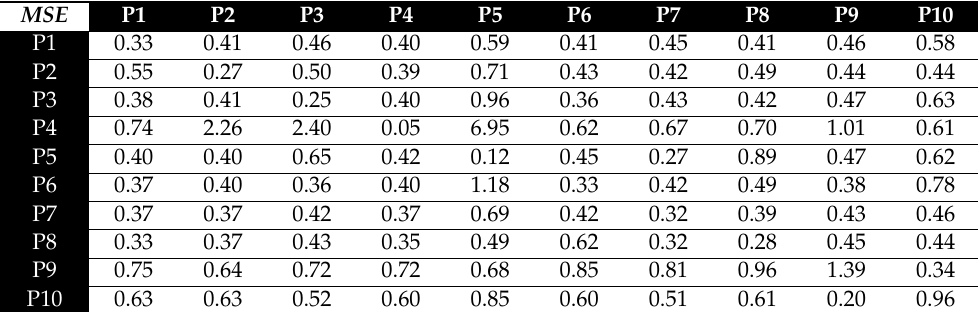
Table 9. MSE values in the second